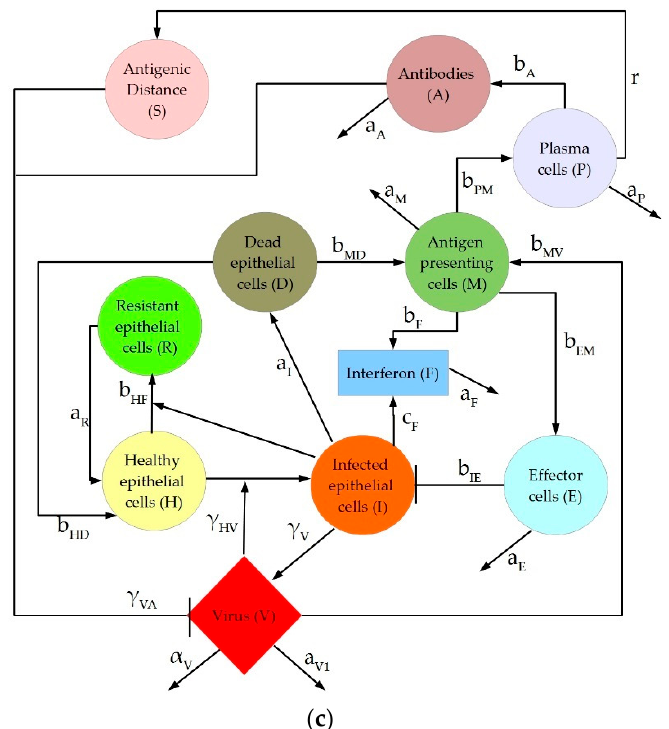
Figure 1. Graphical depiction of interactions represented in the three models discussed in this manuscript: ( a ) Pawelek model; ( b ) Saenz model; ( c ) Hancioglu